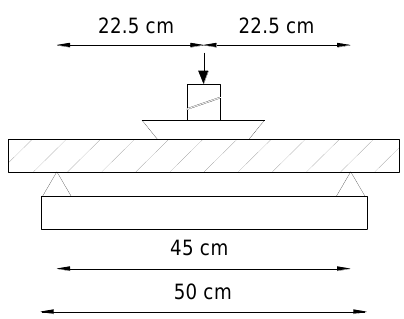
Figure 7. Test scheme for the rupture module.